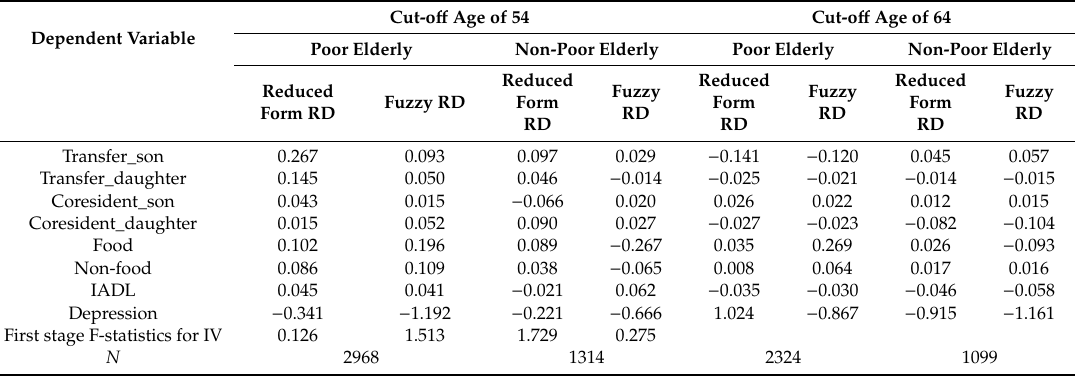
Table A2. Robustness check for alternative cut-o ff